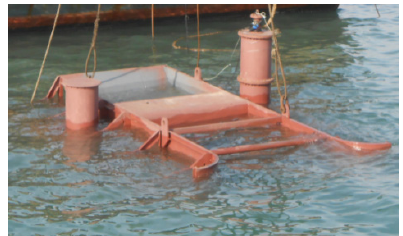
Figure 1. Engineering prototype at the sea trial test.